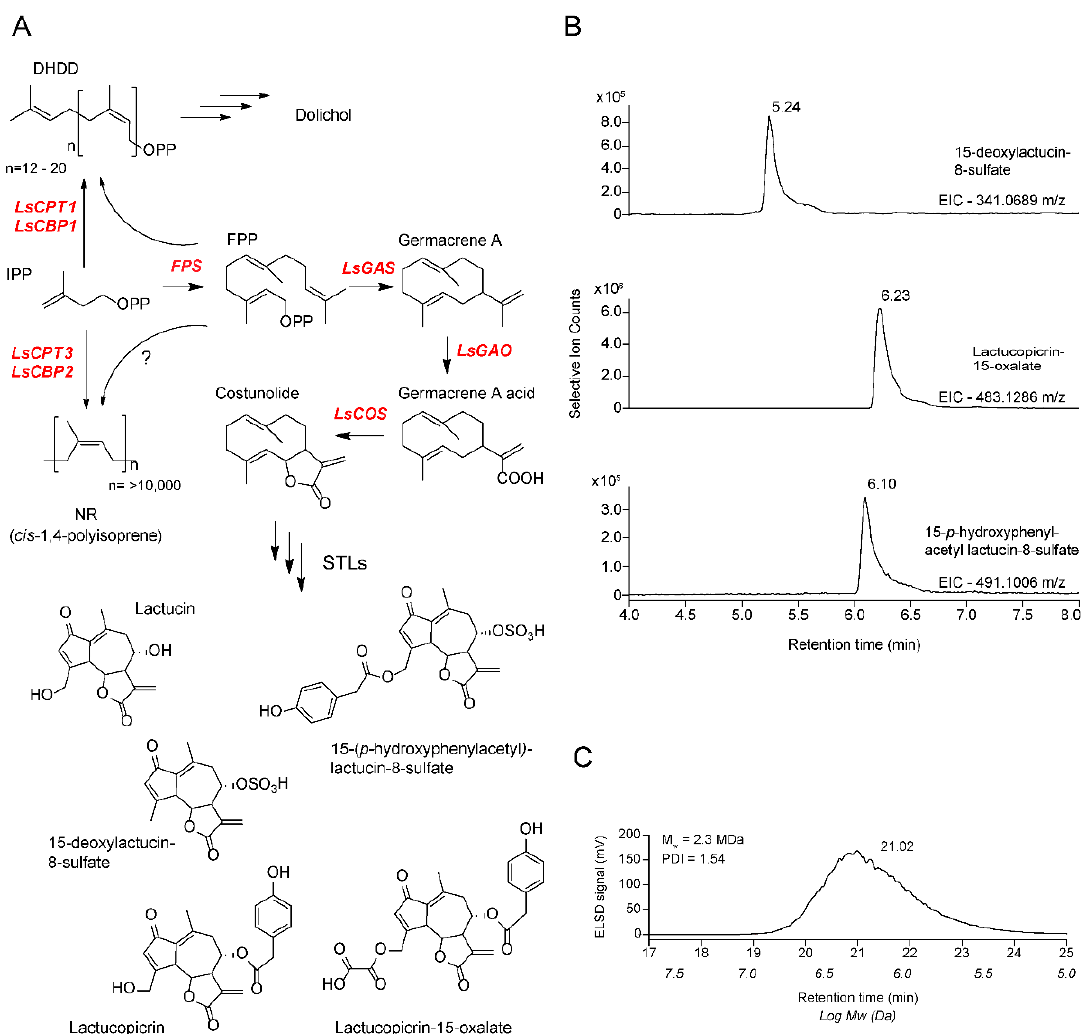
Figure 1. Biosynthetic pathways and metabolite analysis of NR and STLs in lettuce latex. ( A ) Biosynthetic routes of diverse secondary isoprenoids in lettuce latex. ( B ) STL detection in lettuce latex by LC-qTOF. [M+H] + ions were detected in positive ion mode. ( C ) NR detection in lettuce latex by HPLC-GPC (gel permeation column)-ELSD (evaporative light scattering detector). Abbreviations used are: DHDD, dehydrodolichyl diphosphate; STL, sesquiterpene lactone; NR, natural rubber; IPP, isopentenyl diphosphate; FPP, farnesyl diphosphate; PDI, polydispersity index. The key enzymes for each biosynthetic pathway are labeled in red. Representative STL products are shown. Schemes follow the same formatting.